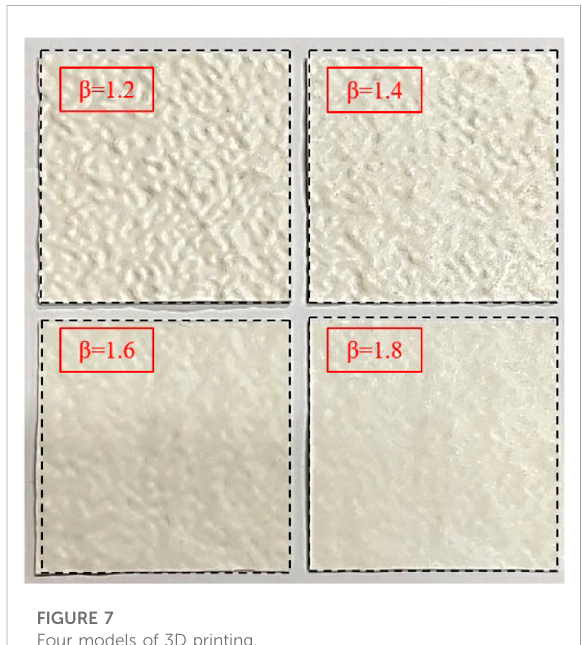
FIGURE 7 Four models of 3D printing.